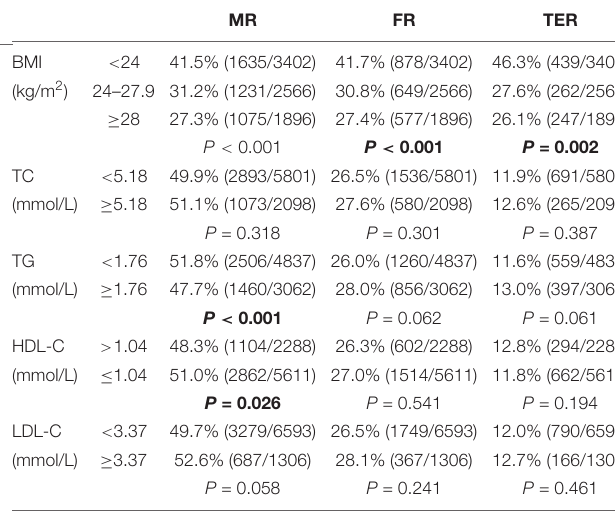
TABLE 2 | Poisson log-linear models of BMI, TC, TG, HDL-C, and LDL-C for the number of oocytes retrieved.